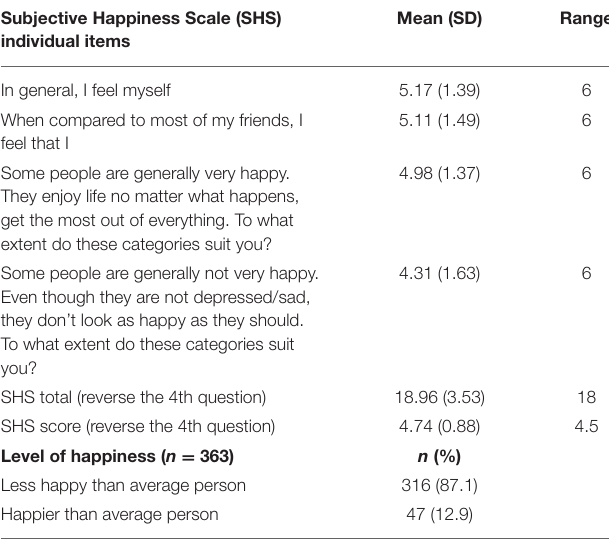
TABLE 4 | Level of happiness among the study participants ( n =